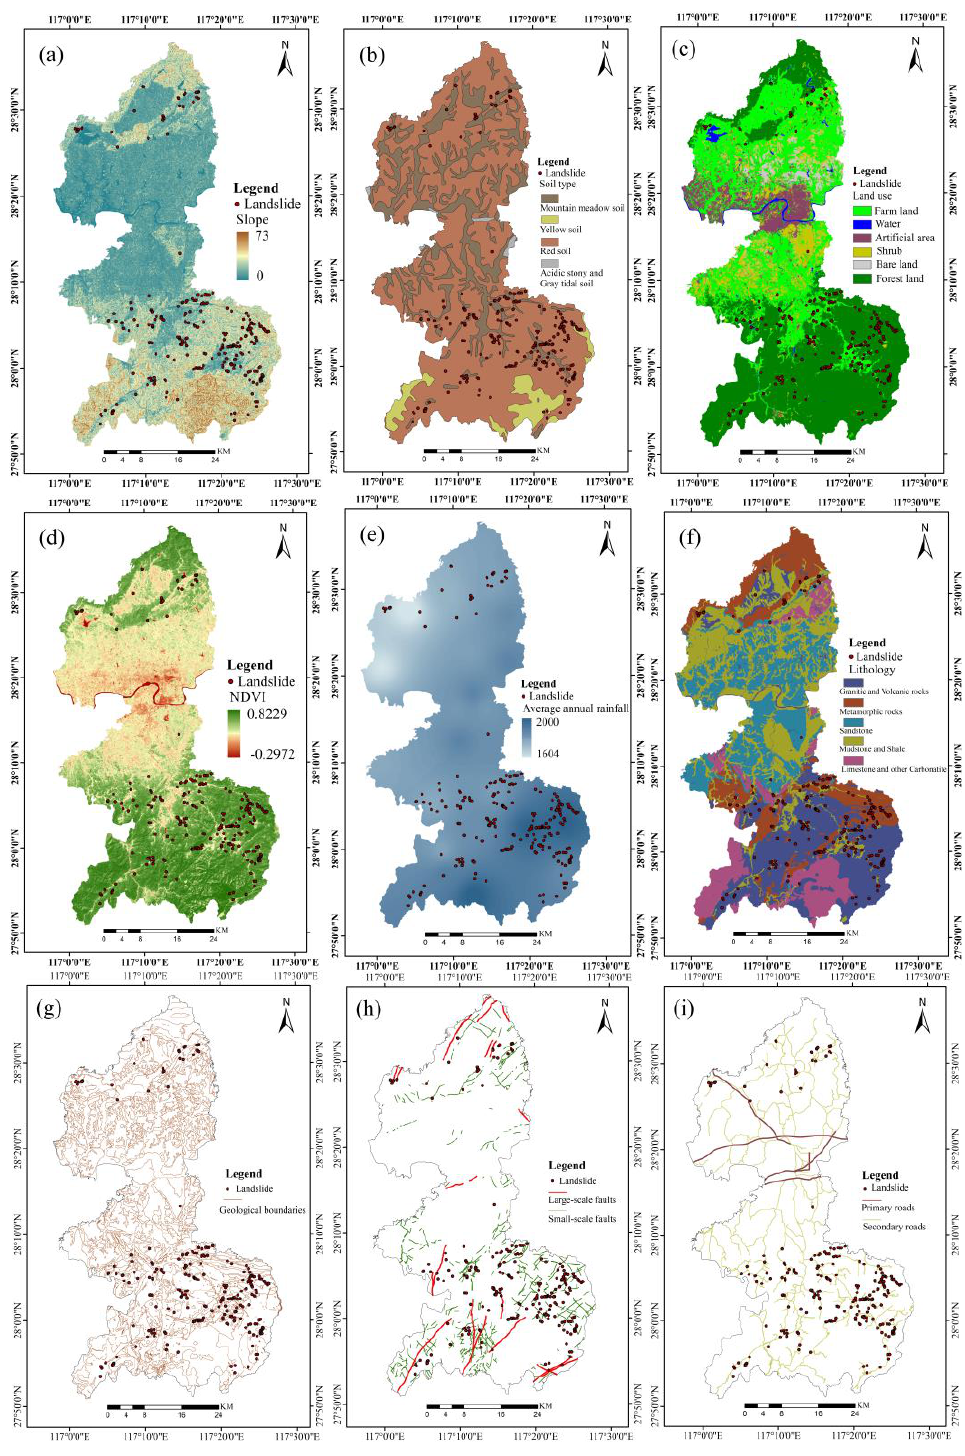
Figure 3. Landslide causal factors used in the study, taking the following factors as examples: (a) slope; slope, ( b ) soil type, ( c ) land use, ( d ) NDVI, ( e ) average annual rainfall, ( f ) lithology, ( g ) geological (b) soil type; (c) land use; (d) NDVI; (e) average annual rainfall; (f) lithology; (g) geological boundaries; boundaries, ( h ) faults, ( i ) (h) faults; (i) roads.